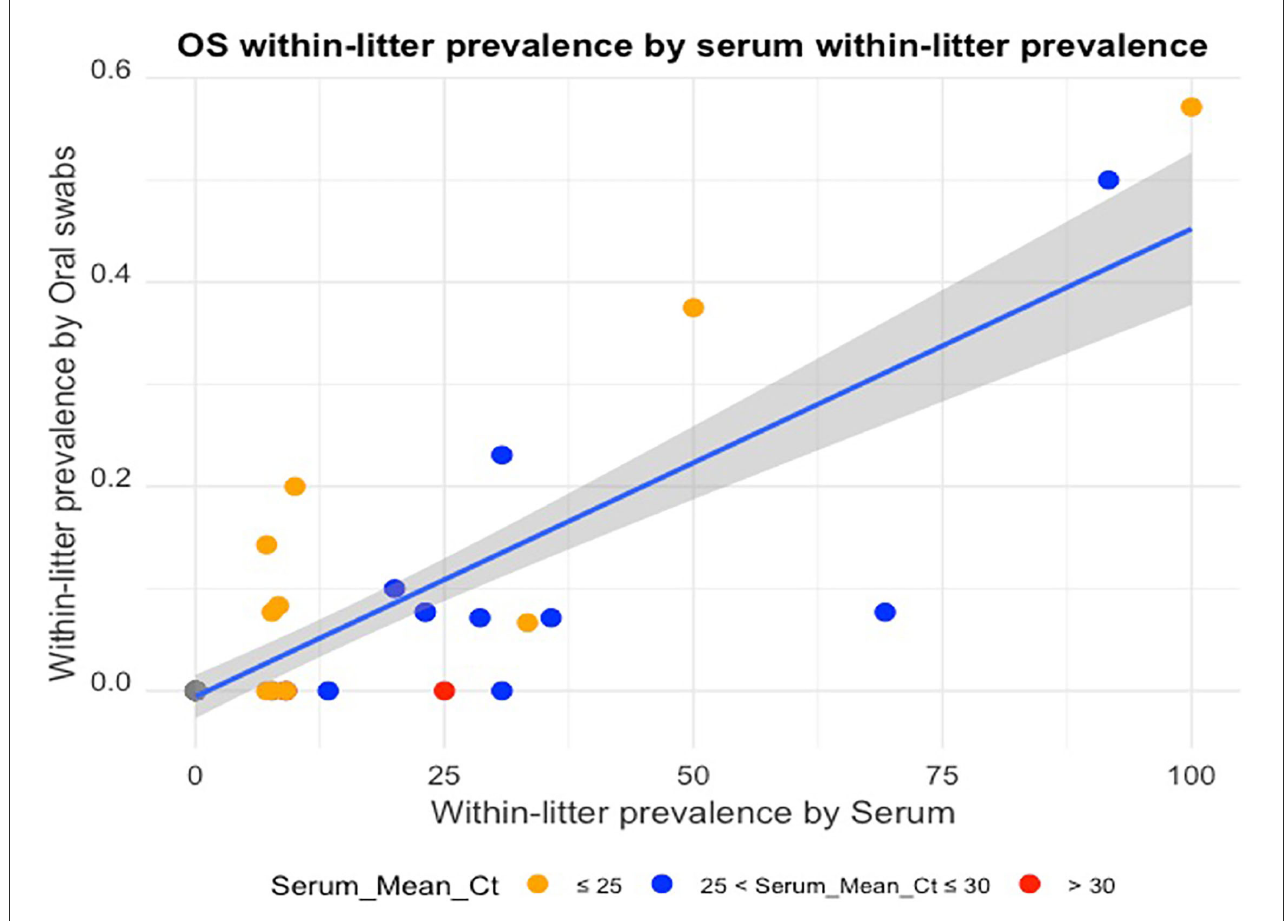
FIGURE1 Oral swab within-litter prevalence plotted against serum within-litter prevalence, with colors indicating mean Ct ranges of the RT-rtPCR-positive serum samples for each litter.